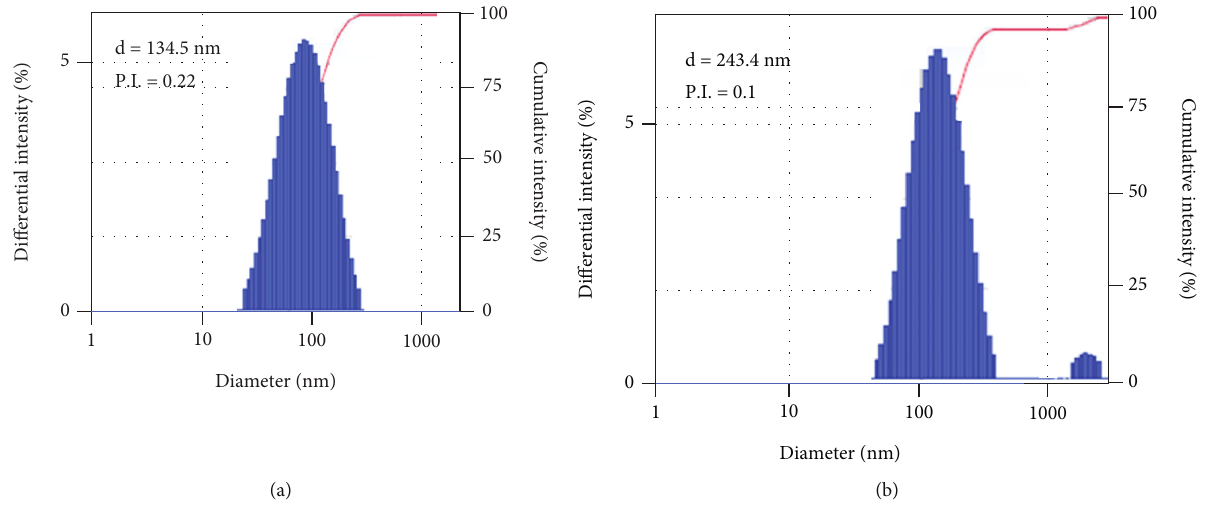
Figure 5: Particle size measurements of (a) NTEPA/Fe